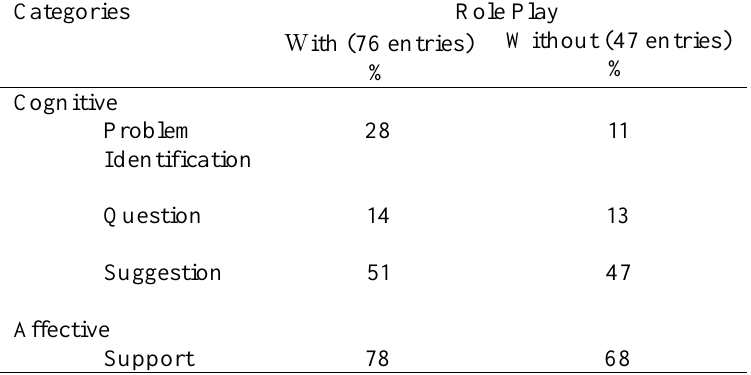
Percentage of the Types of Comments Generated With and Without Role Play